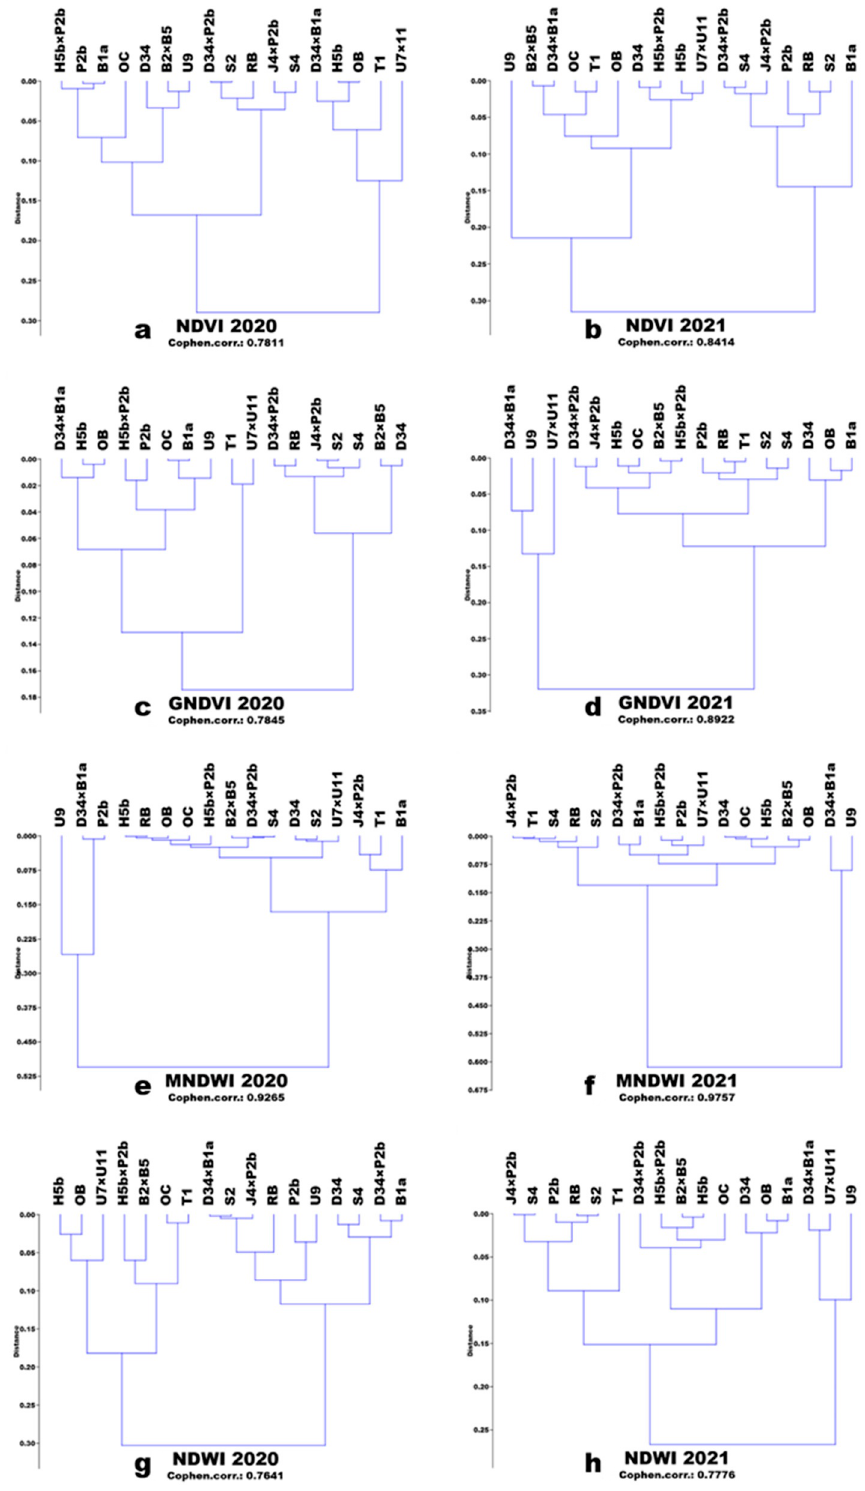
Figure 5. UPGMA cluster analysis of vegetation indexes—( a ) NDVI _2020, ( b ) NDVI _2021 ( c )